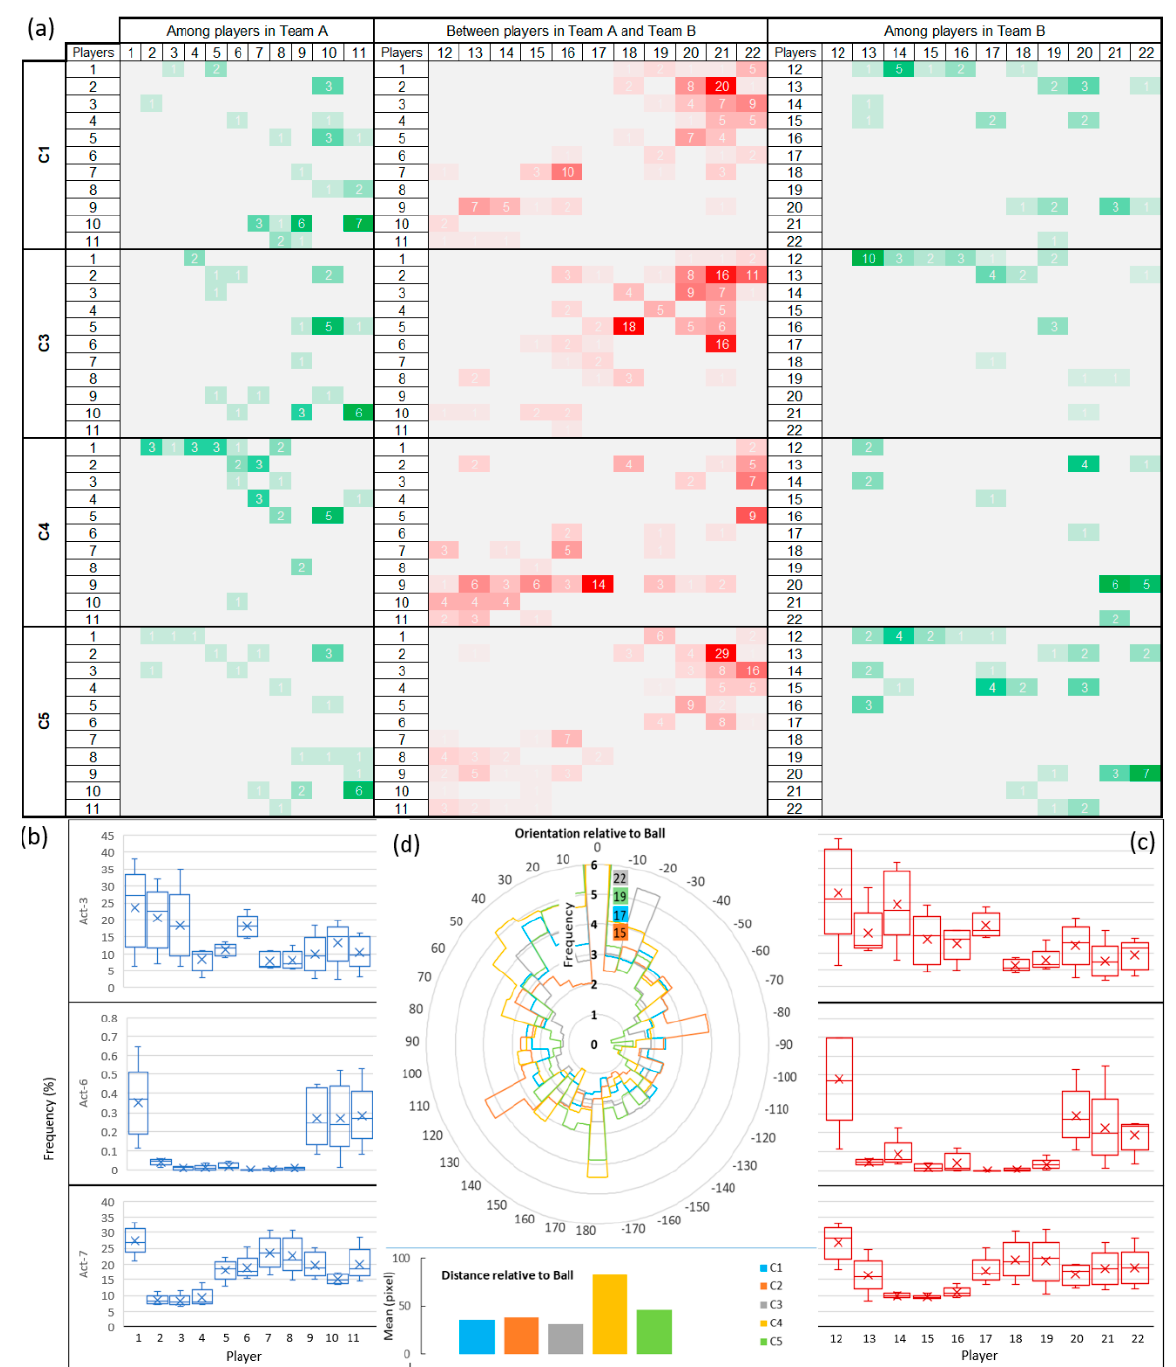
Figure 7. Selection of result visualisations for team, role and individual aspects: ( a ) Changing ball possession among players and between teams for selected configurations. The green colour indicates successful passes among teammates. The red cells show the accumulated number of successful attempts to get the ball (retrieves, tackles, interceptions etc.) from the opposition; ( b , c ) The variation of selected executed actions (attempting ball possession, shooting, running into space) over all configurations, at individual-level. The lower values in Act-6 (the shooting case) are due to the requirement for possession of the ball, making it relatively rare; ( d ) Relative distance and orientation towards the ball for Player 10 only. Some values for the dominant ‘north’ orientation (i.e., towards the ball) beyond the plot extent are represented as numbers according to colour-coded